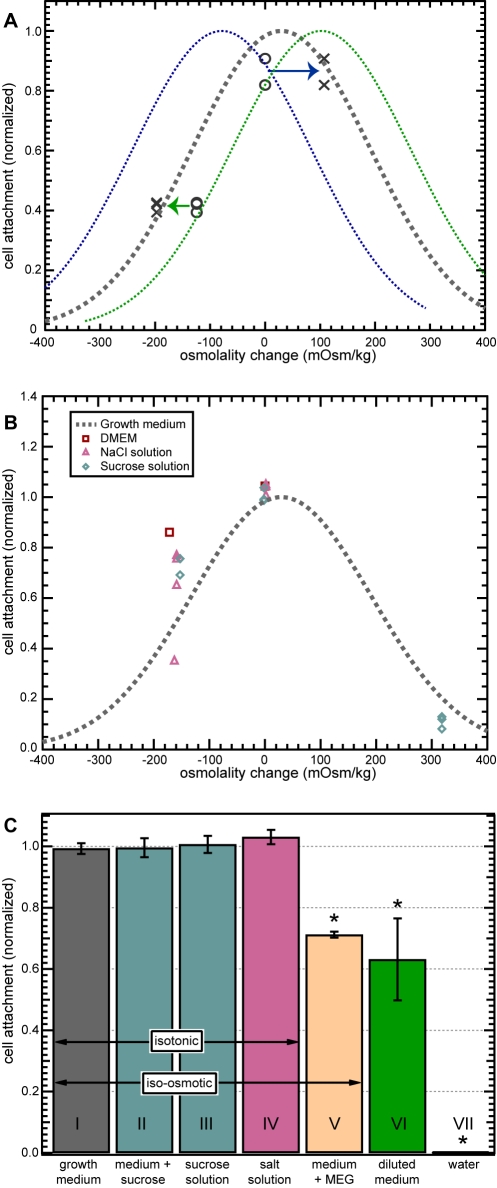
Detachment under changes in solution composition, osmolality, and tonicity.(A) Cells initially incubated in growth media of a slightly higher (green) or lower (blue) osmolality adjusted to the shifted osmolality of the incubation medium. Subsequent exposure to test media of lower and higher osmolality produced detachment in response to the magnitude of the osmotic shift from the new osmolality set point, not the original osmolality. Arrows indicate shift between the observed detachment behavior (circles) and the detachment behavior that would be expected if cells did not adjust (crosses). (B) Cell attachment versus osmotic change in all media used. Dashed line is the fit for attachment results in growth media of varying osmolality (Figure 2B). Similar osmolality-dependent results were found for exposure to DMEM growth medium (squares) and for brief exposure to pure NaCl (triangles) or sucrose (diamonds) solutions. (C) Isotonicity experiments. Bars represent the mean normalized cell attachment at the end of the three-minute experiment. In the presence of growth medium alone, cells did not detach. In medium diluted by half with water, 29% of cells detached (p = 0.00001), while all cells exposed to pure water detached (p<0.000005). This effect can be prevented by restoring the diluted medium to its original tonicity with sucrose, or by substituting a pure, isotonic sucrose or NaCl solution. The effect is not prevented by restoring medium osmolality with cell-permeant mono(ethylene glycol) (MEG), which is iso-osmotic but not isotonic (p = 0.0095). Error bars indicate standard deviation.